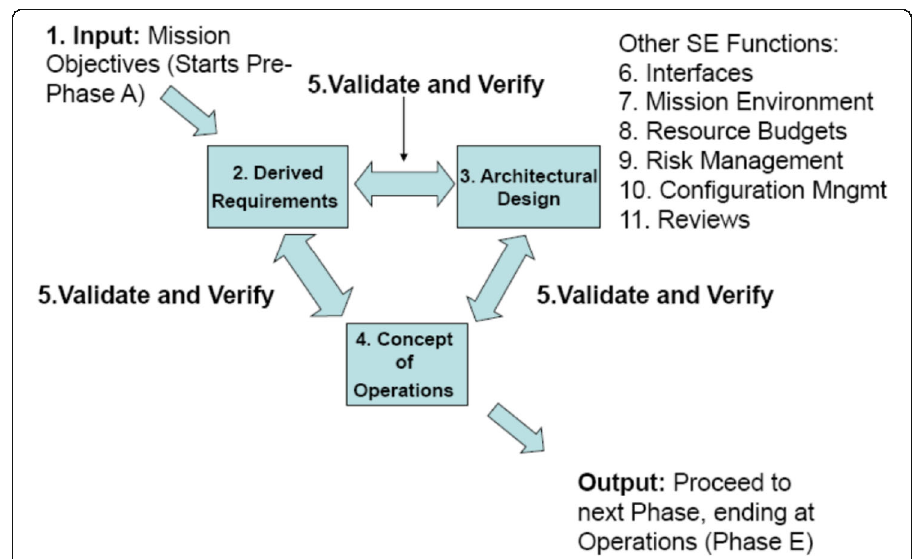
Fig. 2 11 SE Functions in the single systems engineering formula by NASA (NASA